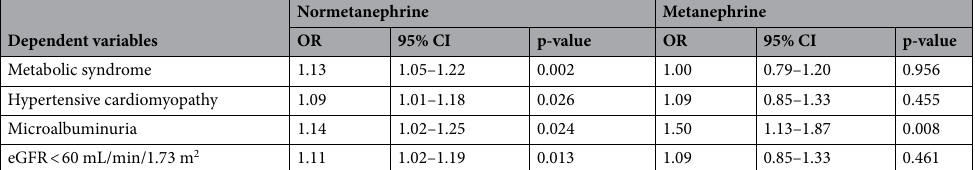
Table 4. Univariate logistic regressions on the association of metanephrines with presence of metabolic syndrome and organ damage (ORs of normetanephrine and metanephrine are calculated for a unit of increase of 100 μg/day). CI, confidence interval; eGFR, estimated glomerular filtration rate; OR, odds